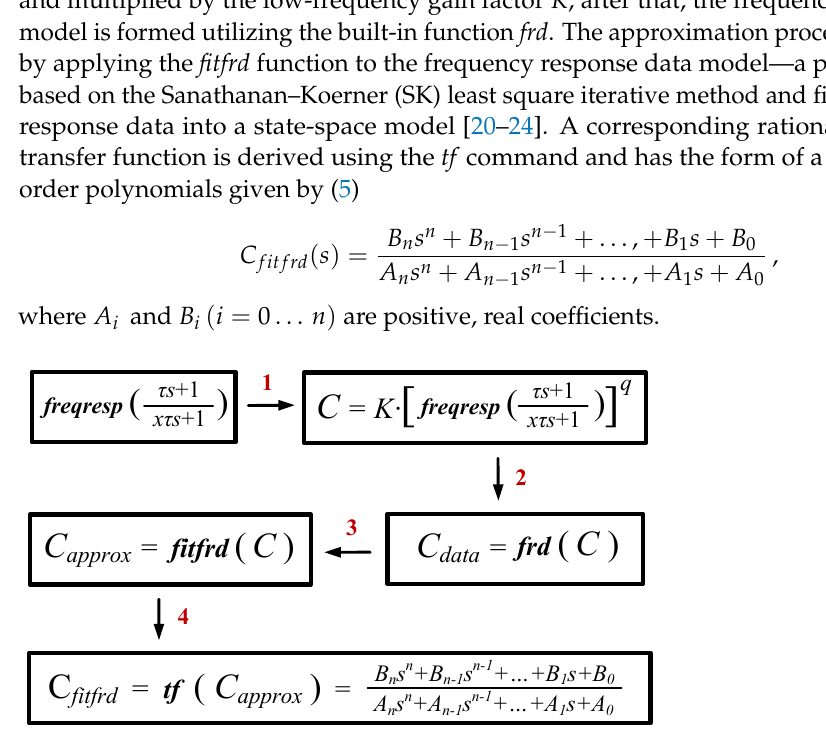
Figure 1. Floating chart description of the curve-fitting-based approximation procedure for approxi- mating the transfer function in